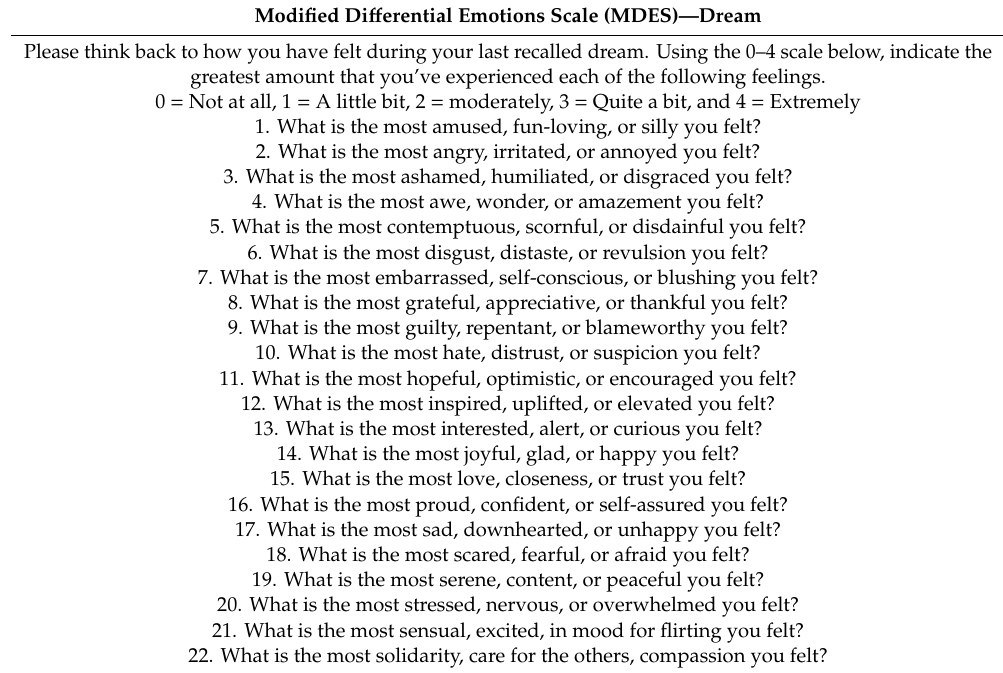
Table A1. Instructions and items of the DREAM